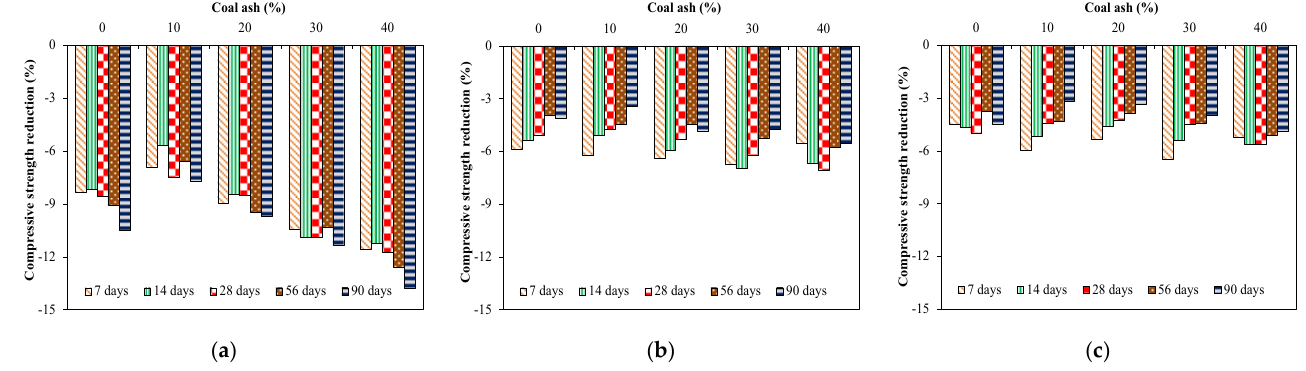
Figure 15. Compressive strength reduction due to ASR conditions: ( a ) no fibers; ( b ) 0.5% fibers; ( c ) 1%